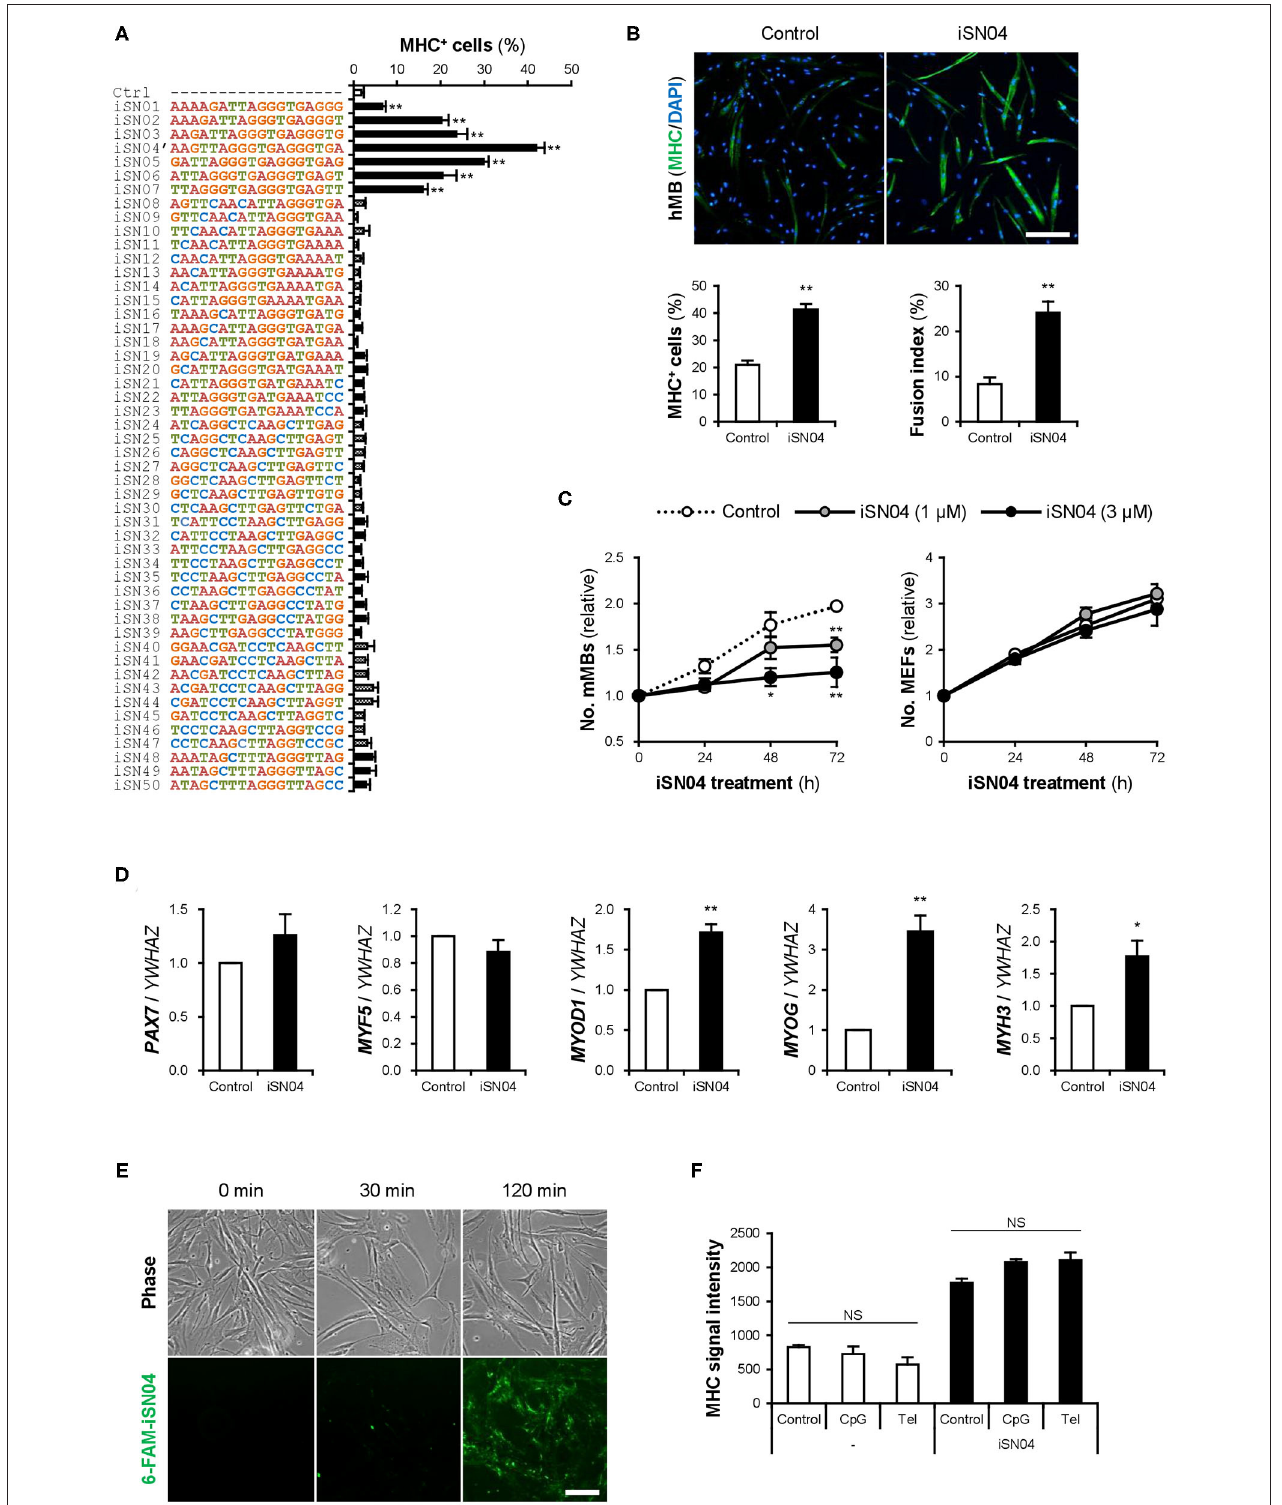
FIGURE 1 | Identification of myoDNs. (A) Ratio of MHC + cells within the screened mMBs treated with 10 µ M PS-ODNs in GM for 48h (screening system). ** p < 0.01 (Dunnett’s test). n = 3. (B) Representative immunofluorescent images of the hMBs treated with 10 µ M iSN04 in DM for 48h. Scale bar, 200 µ m. Ratio of MHC +